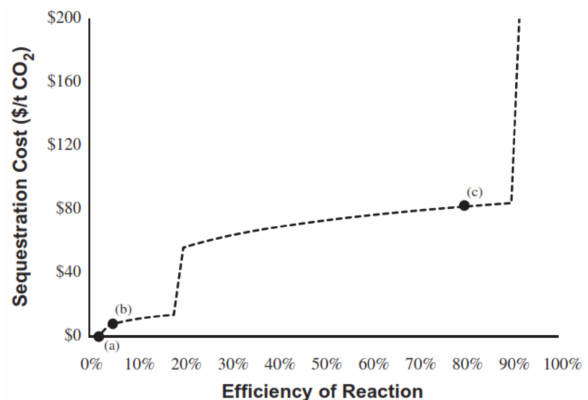
Figure 6. Conceptual model of mineral carbonation cost versus efficiency for various methods of mineral carbonation. Corroborating data points: ( a ) natural alteration; ( b ) heap leaching; and ( c ) autoclave reaction. Reprinted with permission from Hitch and Dipple [122]. Copyright